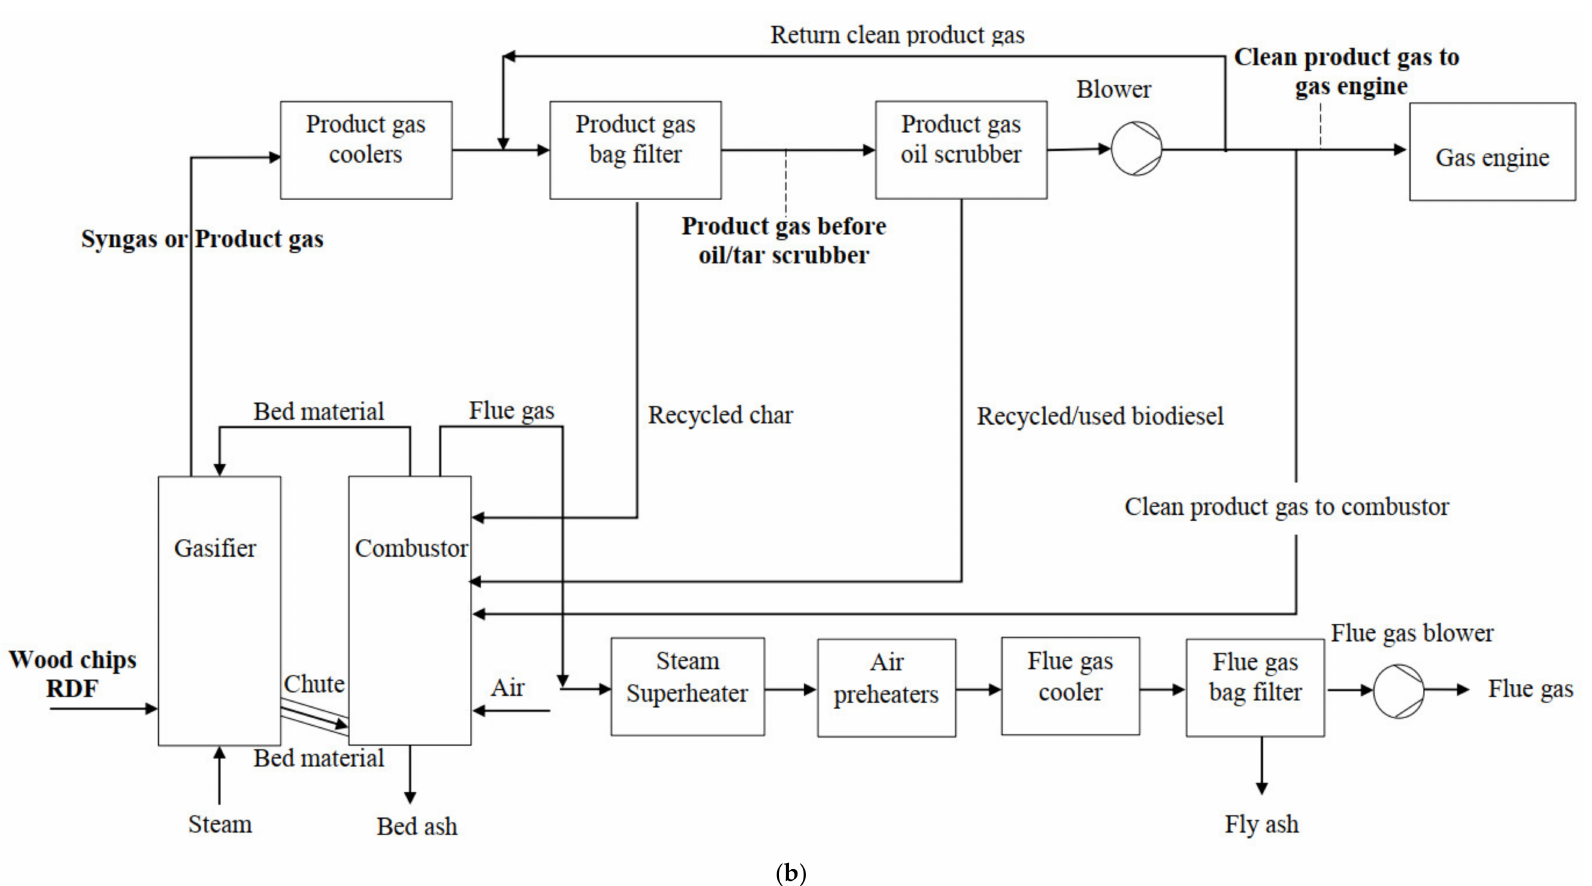
Figure 3. Schematic diagram of the CHP–DFB biomass gasifier process at Nong Bua district in Thailand: ( a ) diagram figure extracted from the SCADA system in a control room of the power plant and ( b ) simplified process